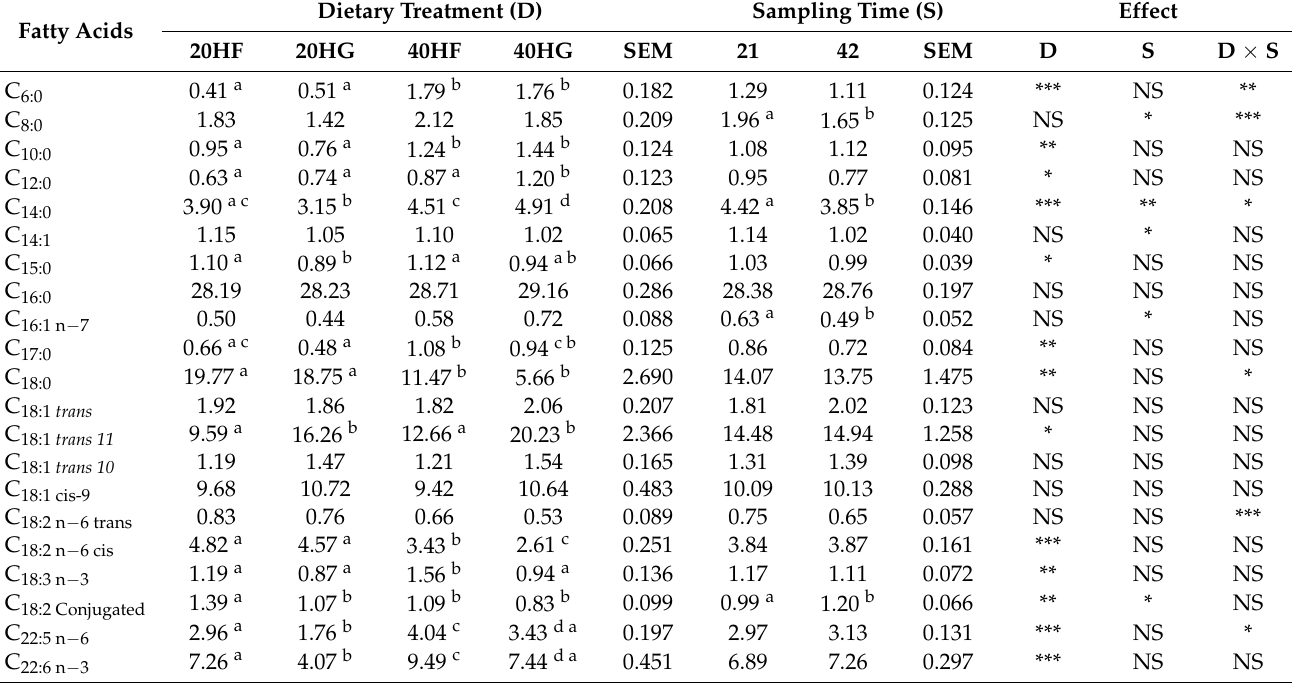
Table 7. The mean individual fatty acids (FA) (% of total FA) in rumen fluid of goats fed diets (20HF, 20HG, 40HF, and 40HG) with different levels of microalgae Schizochytrium spp. (20 g and 40 g/day/goat) and two different forage to concentrate ratios (60:40 and 40:60) throughout the experimental period (21st and 42nd experimental day) using a GLM model for repeated